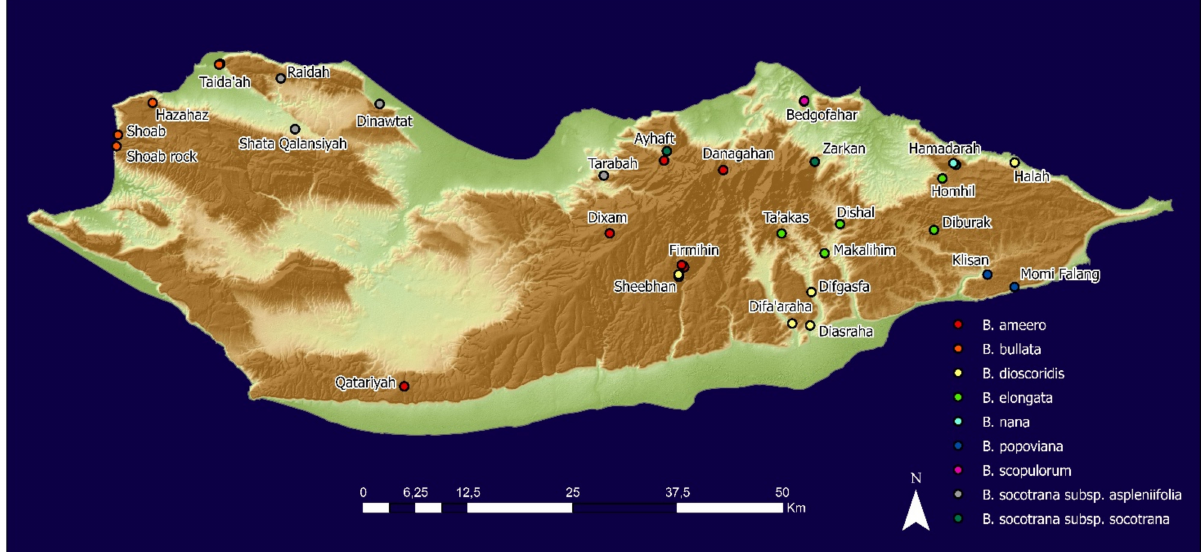
Figure 10. Map of the study area (Socotra Island, Yemen) showing the locations where seeds of Boswellia species were